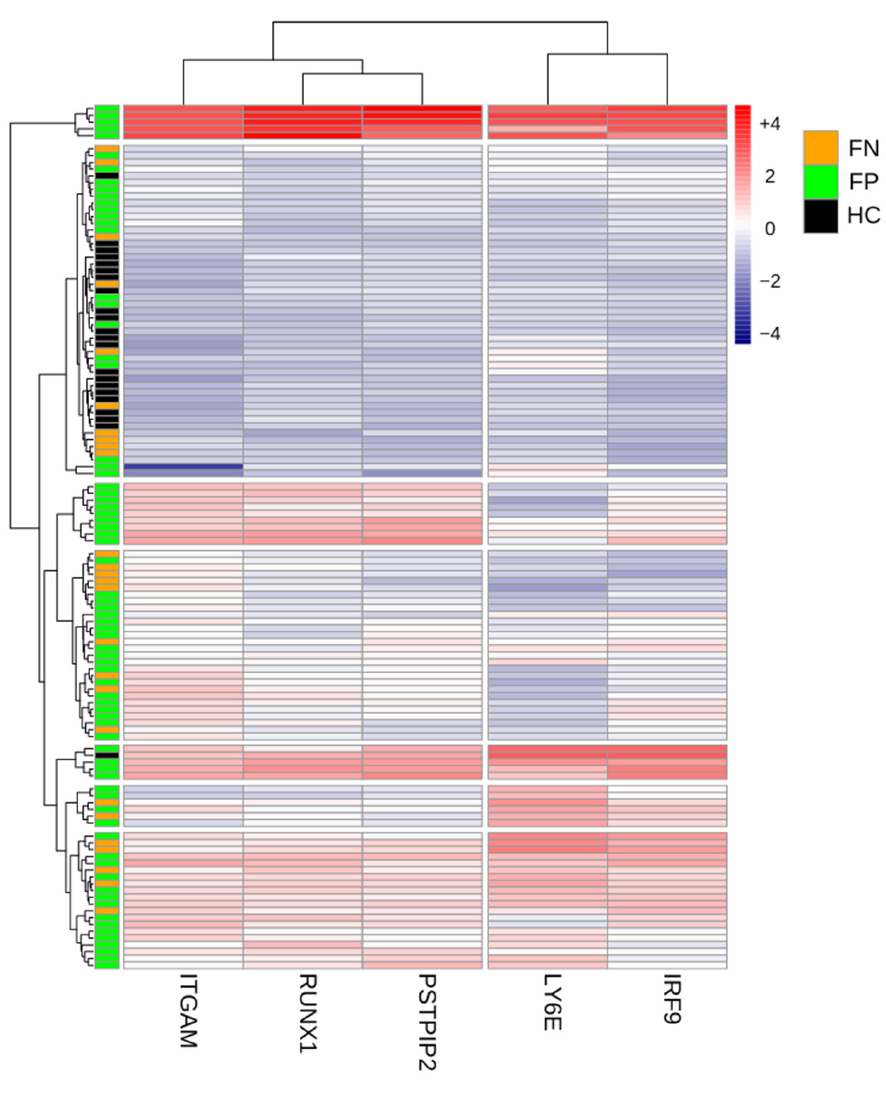
Figure 4. Heat map of the five expressed genes from the FP group, FN group, and HC group. Rows represent the subjects, and columns represent genes. Gene expression levels are color-coded; red and blue represent high (+4) and low ( − 4) expression levels, respectively.